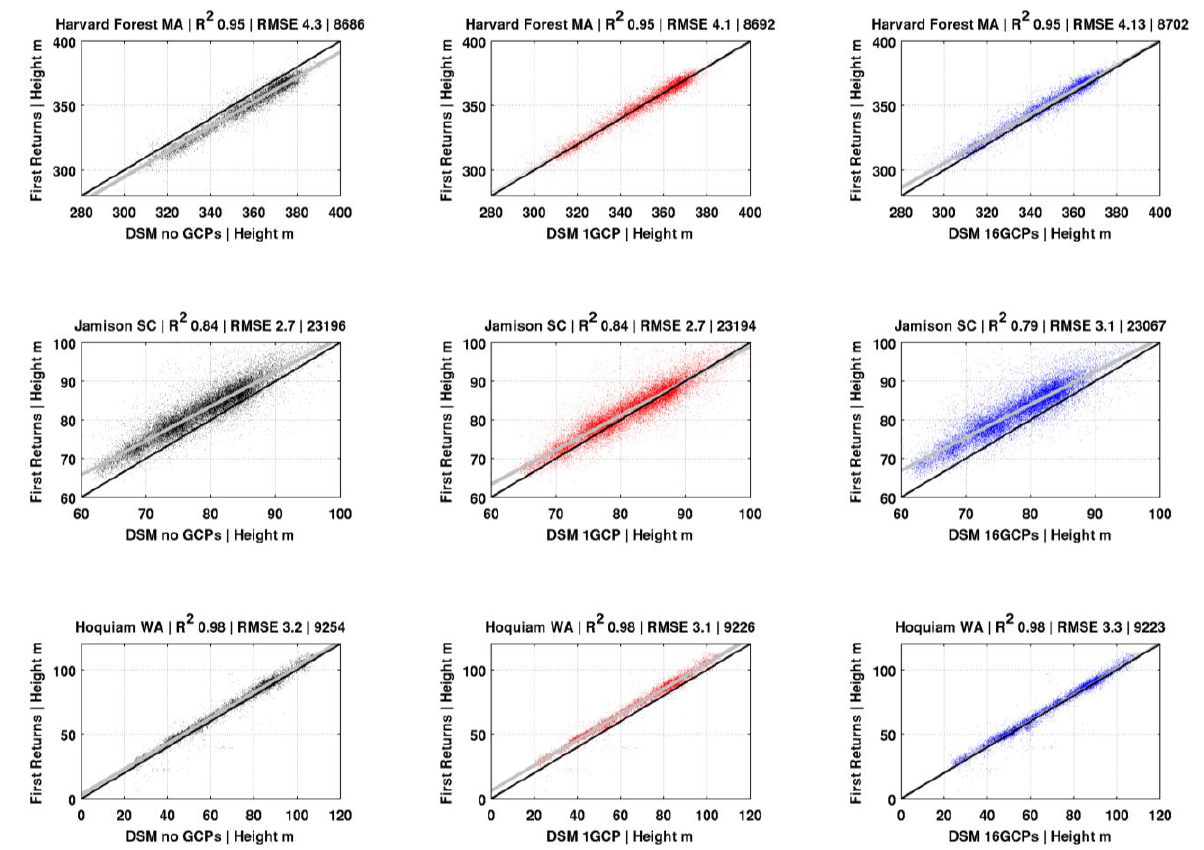
Figure 4. Scatter plots of three study regions using a standard normal distribution of pixels randomly sampled with totals indicated in plot title. Three types of DSMs from IKONOS were compared to G-LiHT LiDAR first returns. Values not meeting criteria in Table 2 were excluded from analysis. The colors from left to right indicate no ground control points (GCPs) in black, one GCP in red, and 16 GCPs in blue. The black line indicates a one-to-one relationship and the gray line indicates a least squares linear fit.